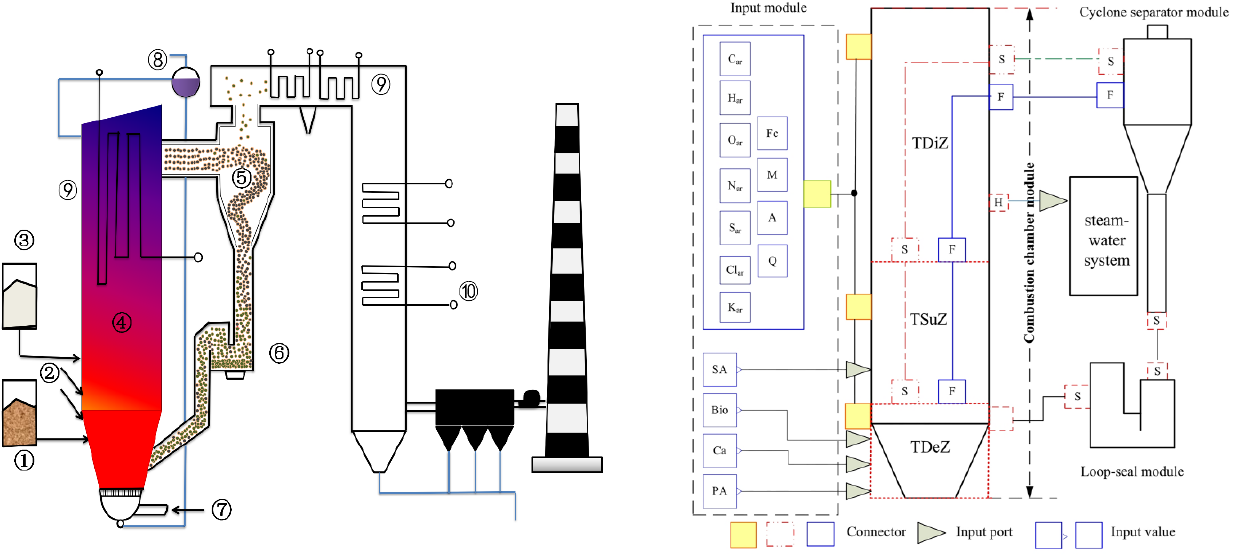
Figure 1. Structure of 130 t/h circulating fluidized bed boiler with model structure schematic. ① Biomass fuel ② Secondary air ③ Limestone ④ Boiler chamber ⑤ Separator ⑥ U-shaped return valve ⑦ Primary air. ⑧ Steam package ⑨ Superheater ⑩ Coal saver.